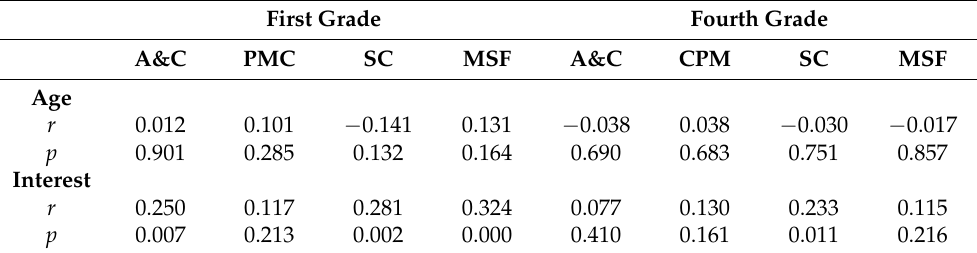
Table 7. Correlations between EBBCAM and participants’ age and interest in death. First Grade Fourth Grade